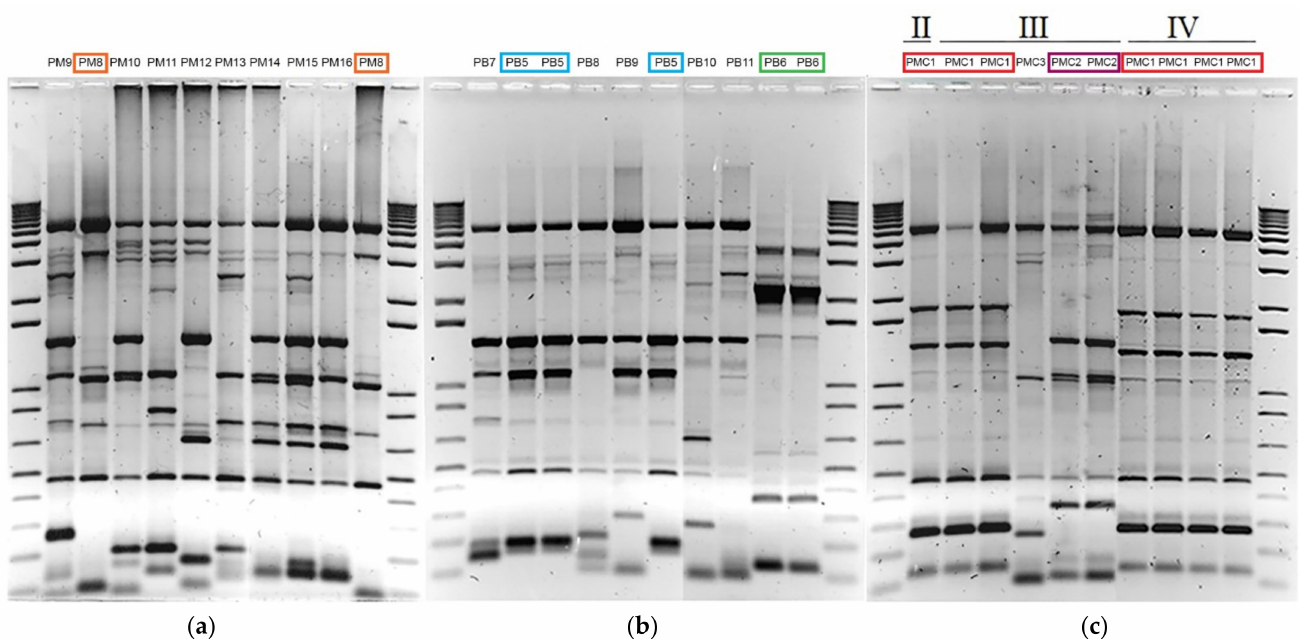
Figure 2. Diversity, dominance and perenniality of S. cerevisiae isolates in wineries. ( a ) A single dominant profile (PM8, framed in orange) is found in the same vat of winery M. ( b ) Two dominant profiles (PB5 in blue and PB6 in green) are found in the same vat of winery B. ( c ) One profile (PMC1 in red) of winery MC is found during several years and in different vats of year III. PMC2 (in violet) is found in the same vat of year